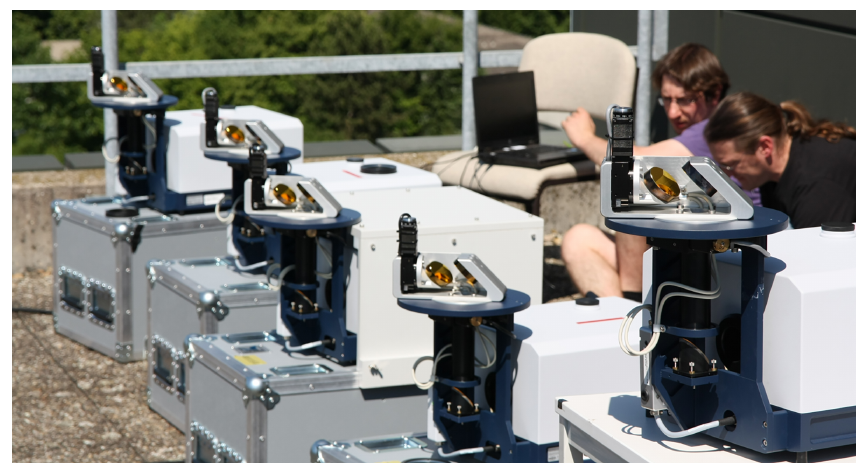
Figure 10. Calibration measurements performed on 14 April 2015 on top of the KIT-IMK office building north of Karlsruhe.